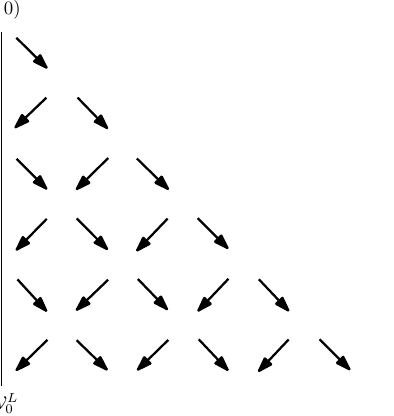
Figure 2. Arrangement of steps for points of L in presence of restriction W L